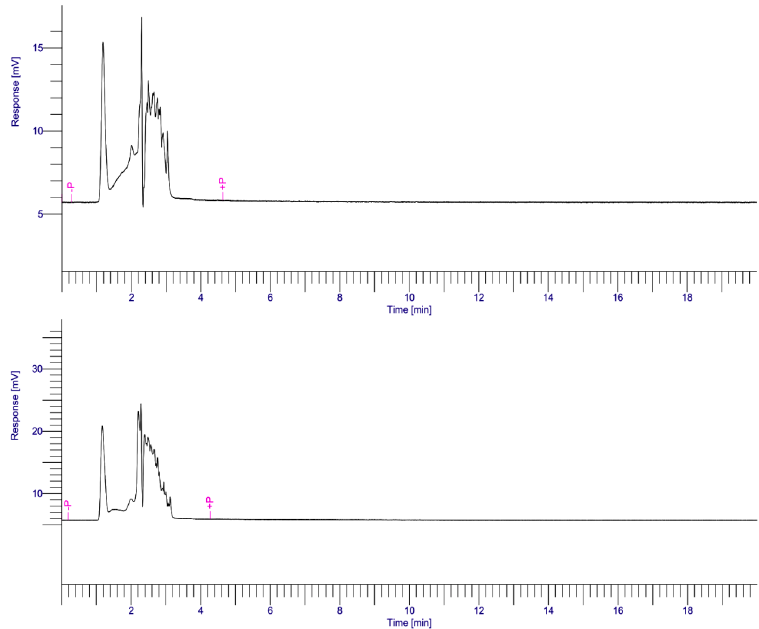
Figure 4. Representative chromatogram profiles of free UB solution ( upper ), receptor medium of free UB group ( middle ) and UB-NLC group ( lower ) studied under optimum conditions. The peak eluted at about 12.4 min, which was the characteristic peak.